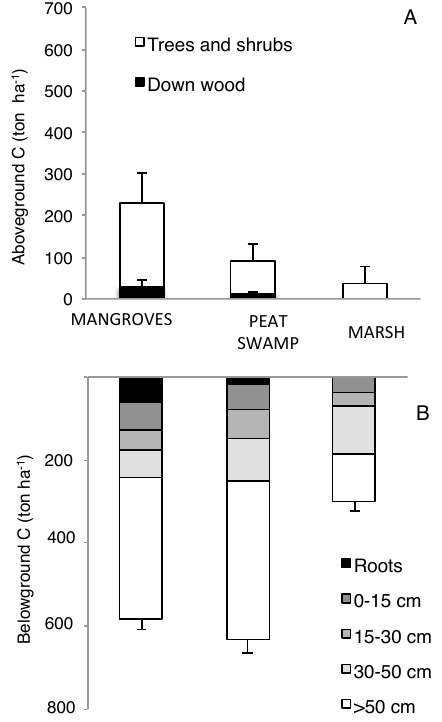
Figure 2. Aboveground (a) (trees and shrubs and down wood) and belowground (b) (soil at different depths and roots) carbon stocks (MgCha − 1 ) of mangroves, peat swamp forests and marsh wetlands within La Encrucijada Biosphere